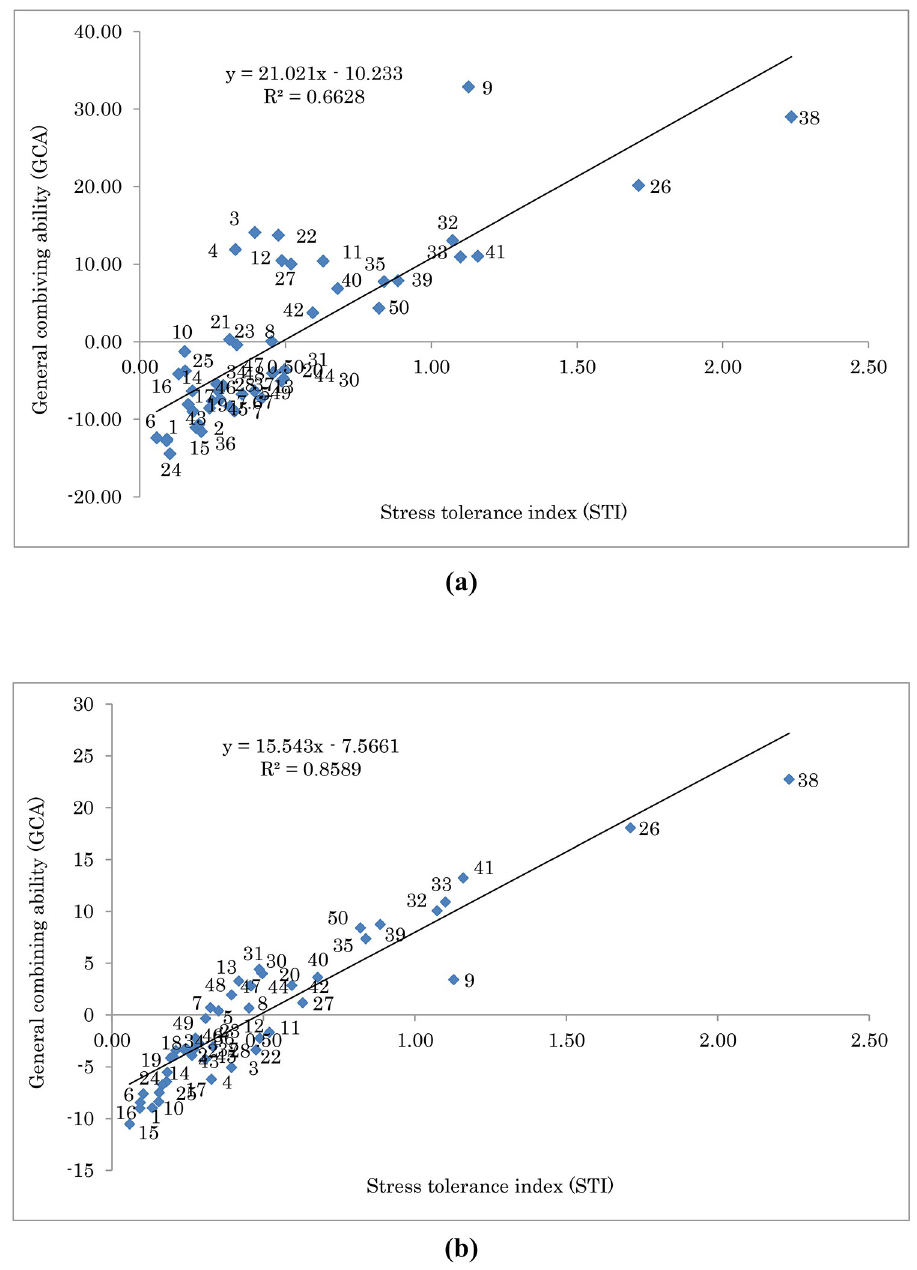
Fig 6. Biplot of general combining ability (GCA) vs. stress tolerance index (STI) for 49 open-pollinated (OP) populations of fennel under normal (a) and water deficit (b) conditions. The F-test indicated that the model is significant for normal and water deficit conditions in 0.01 probability